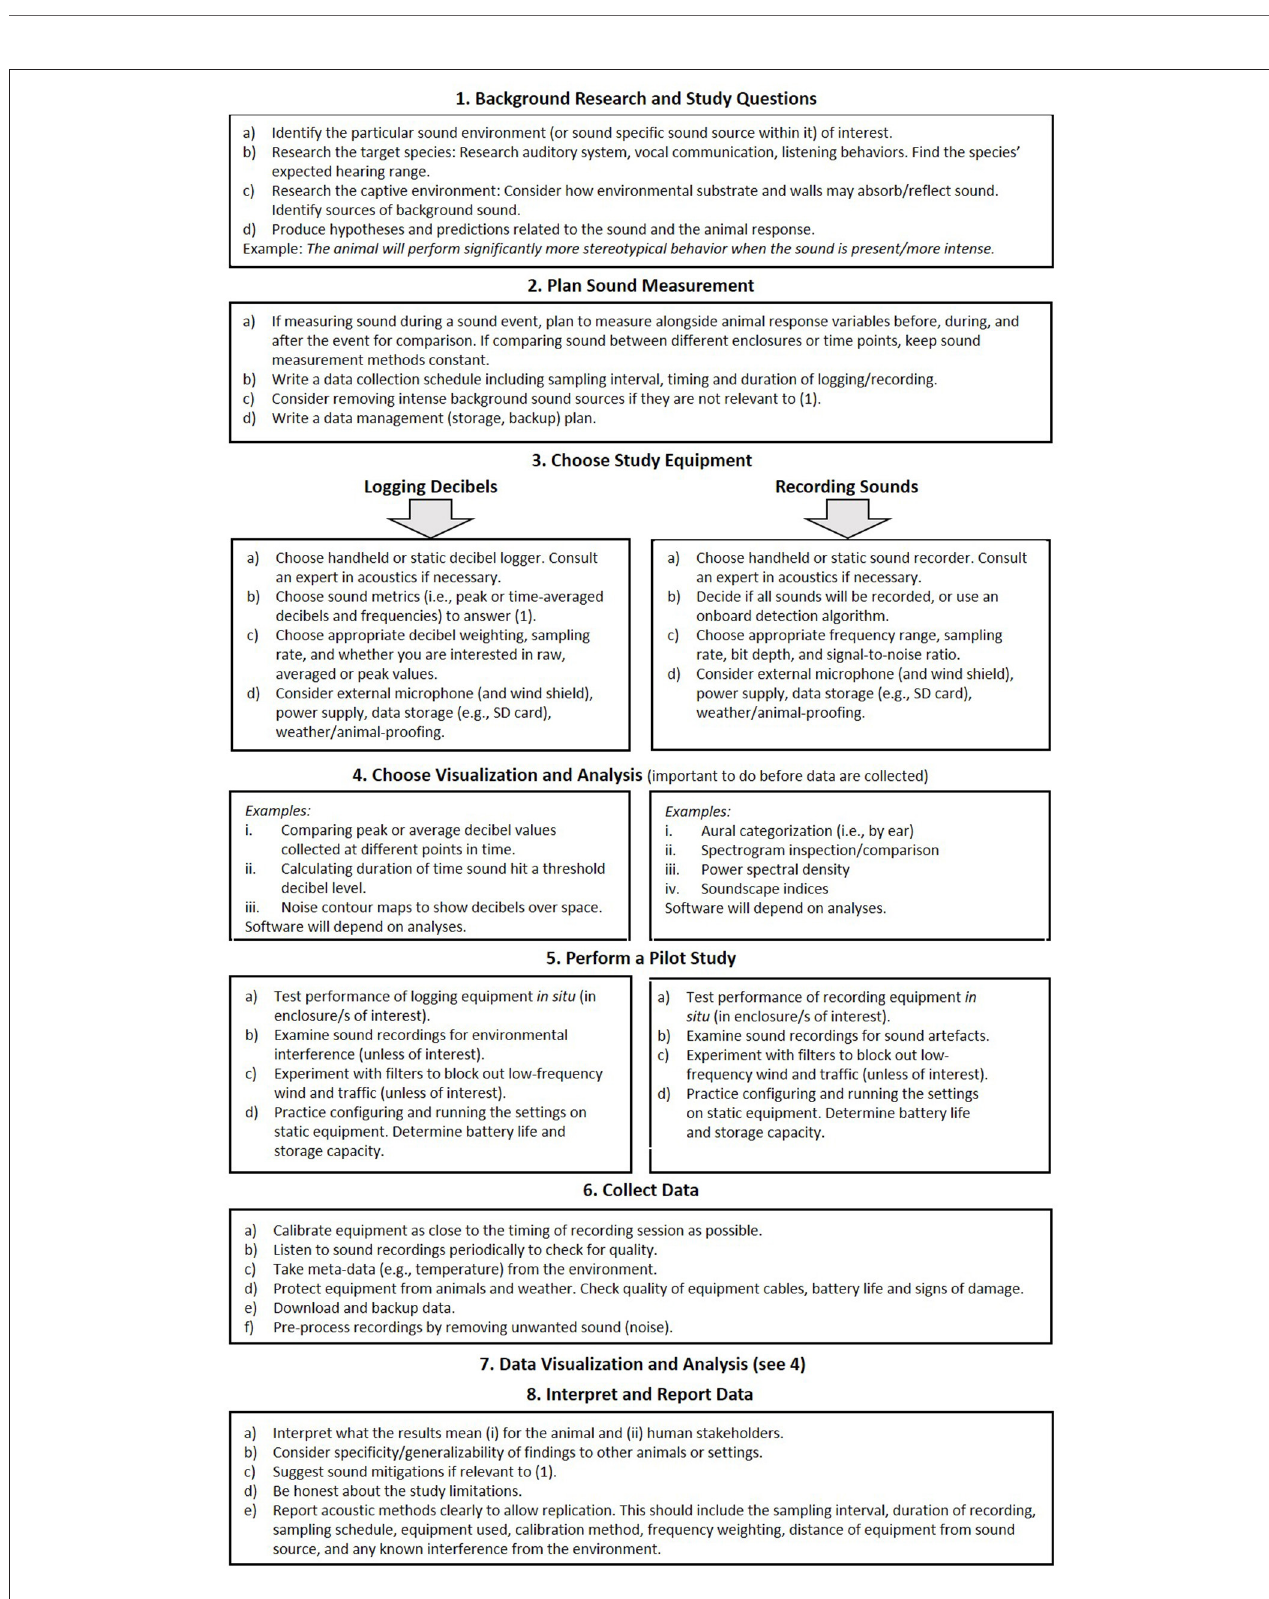
FIGURE 5 | A practical workflow to monitor sound in captive environments.